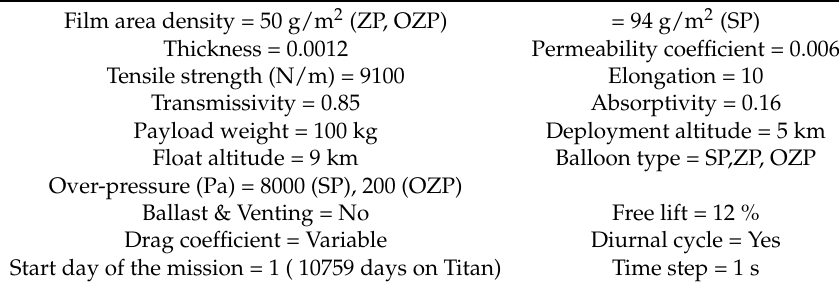
Table 6. Titan aerobot parameters. Parameters are based on [56,59].